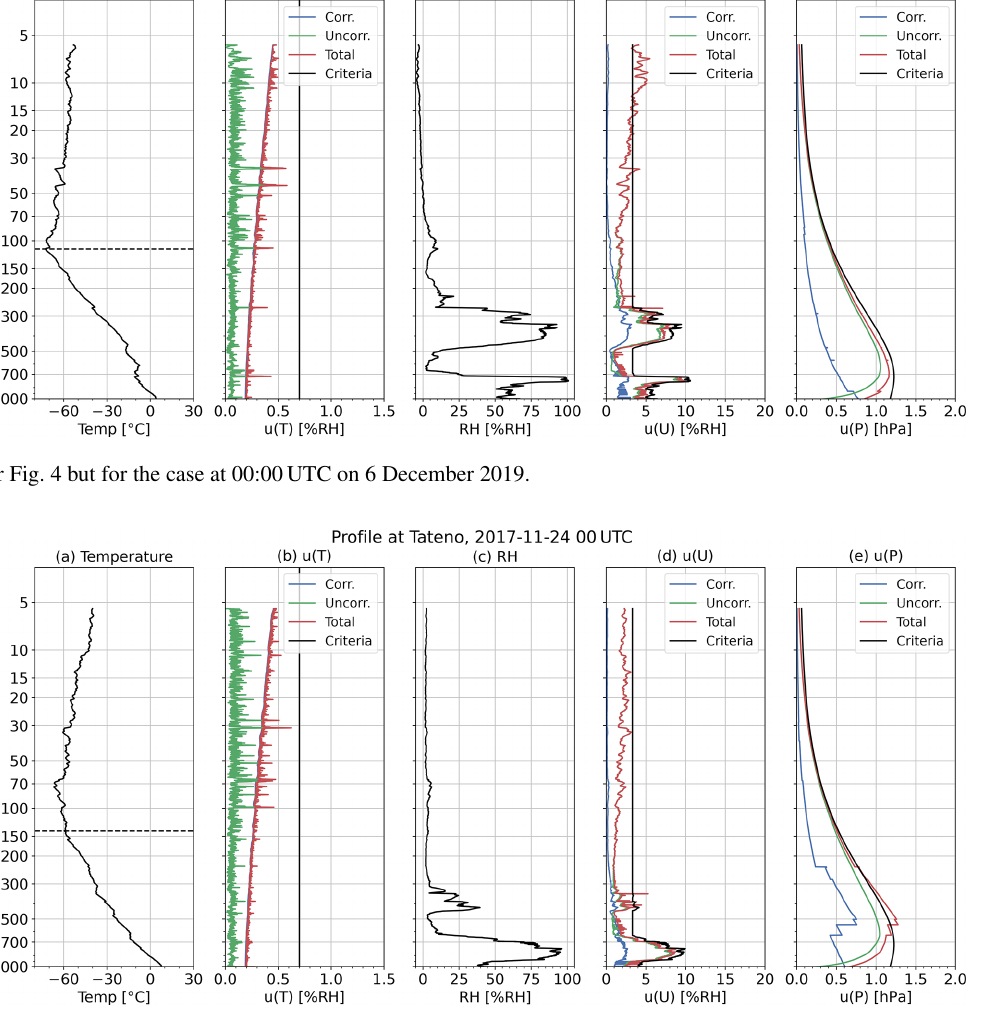
Figure 13. As per Fig. 4 but for the case at 00:00UTC on 24 November